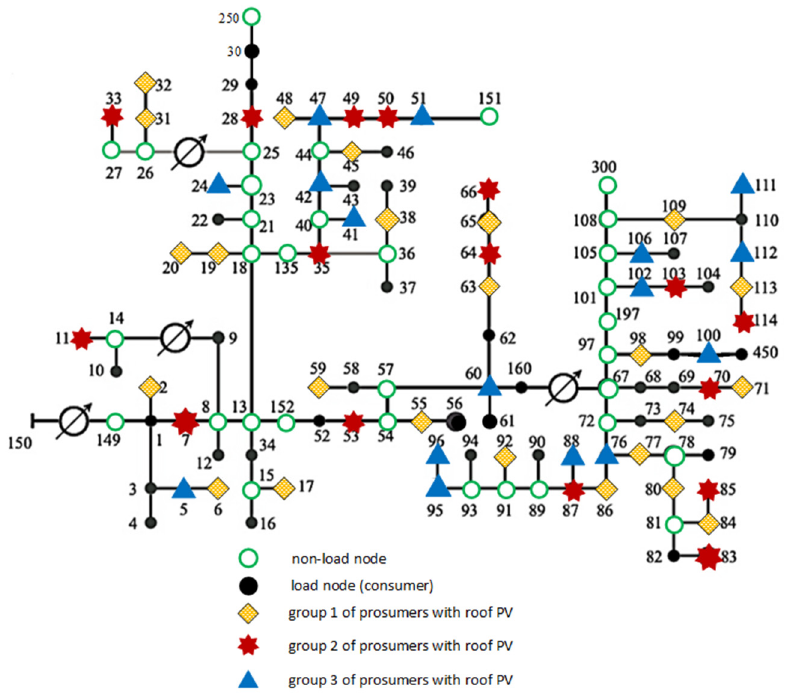
Figure 4. Single-line diagram of the IEEE 123 Node Test Feeder with different levels of prosumers’ penetration.